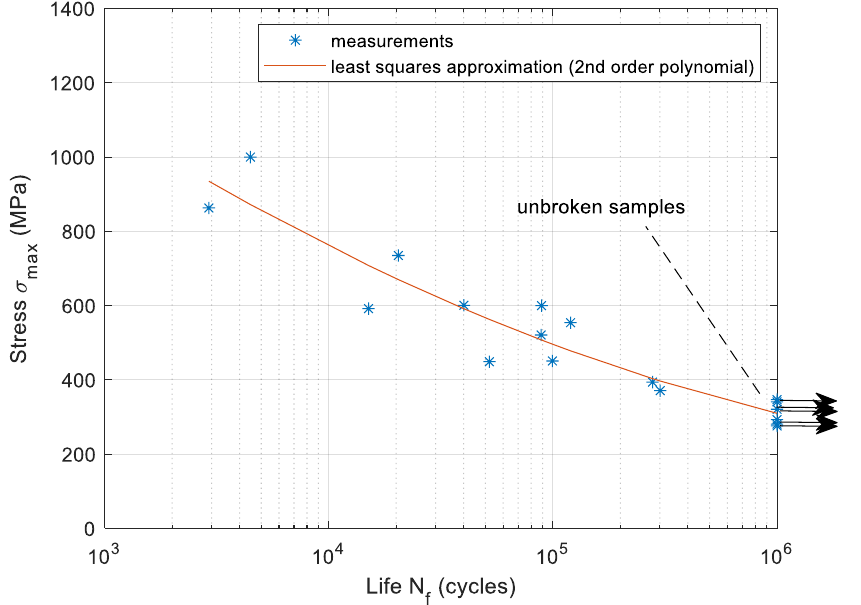
Figure 7. The S–N curve for AM maraging steel for pressure fatigue load, R = 0.